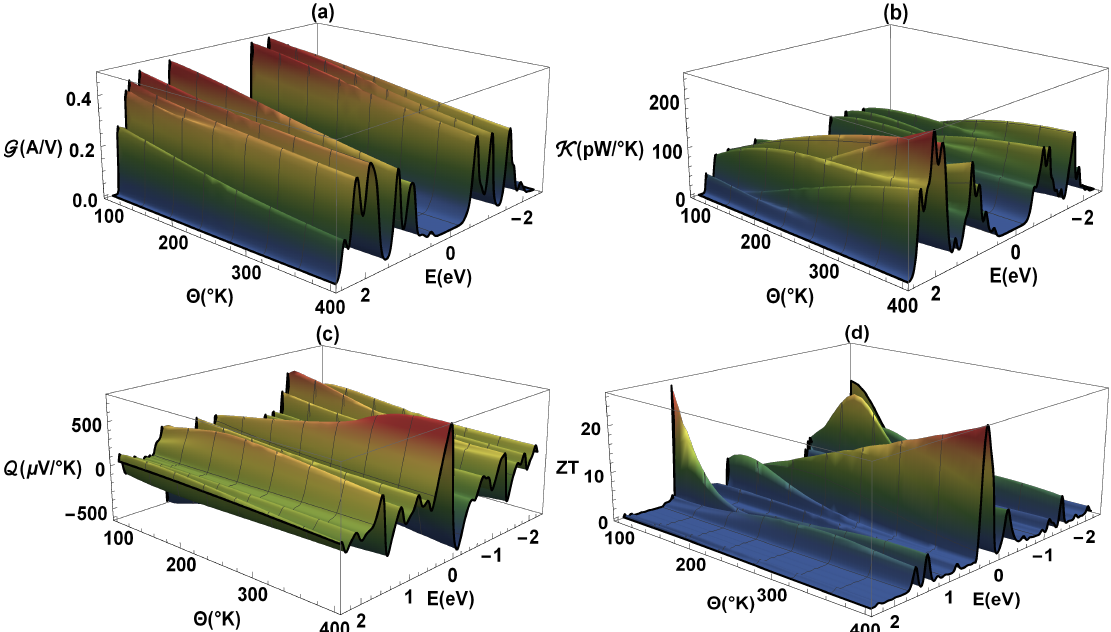
Figure 5. ( a ) Electrical conductance ( G ), ( b ) thermal conductance ( κ ), ( c ) Seebeck coefficient ( Q ), and ( d ) ZT as a function of energy and temperature ( Θ